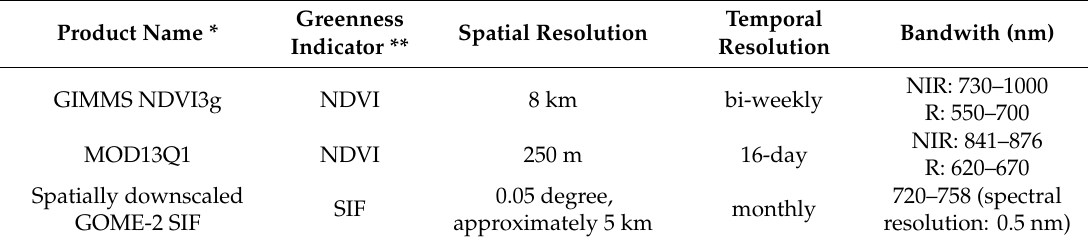
Table 1. Three satellite-based greenness datasets (2007–2013) for the